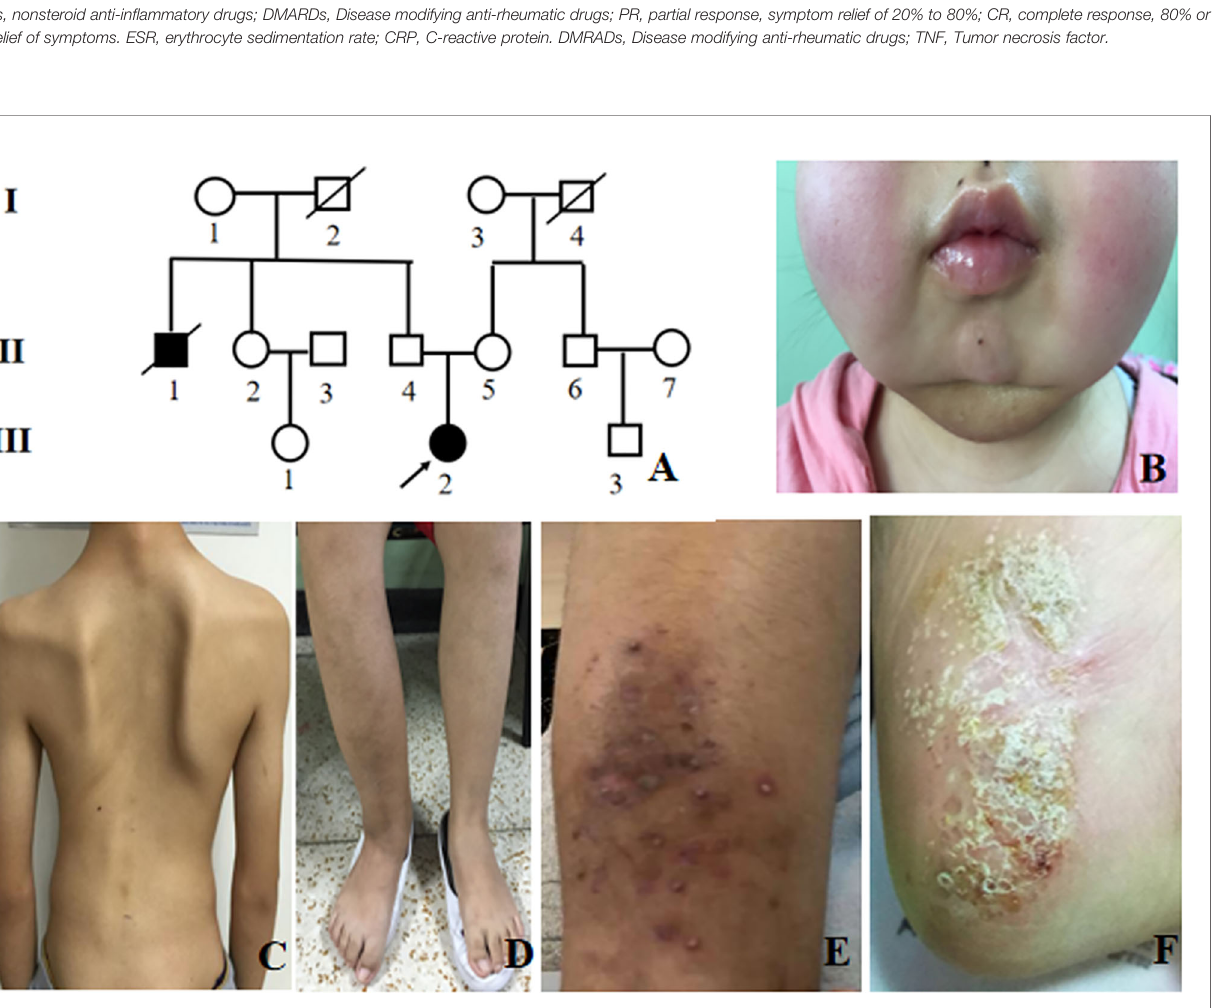
FIGURE 1 | Clinical presentation of CNO patients. (A) Pedigree of patient 6 . The a rrow indicates the proband. Black symbols indicate affected individuals; (B) Bilateral mandible involvement; (C) Spinal deformity; (D) Right tibio fi bular deformity; (E) Psoriatic rash; (F) Plantar pustules.